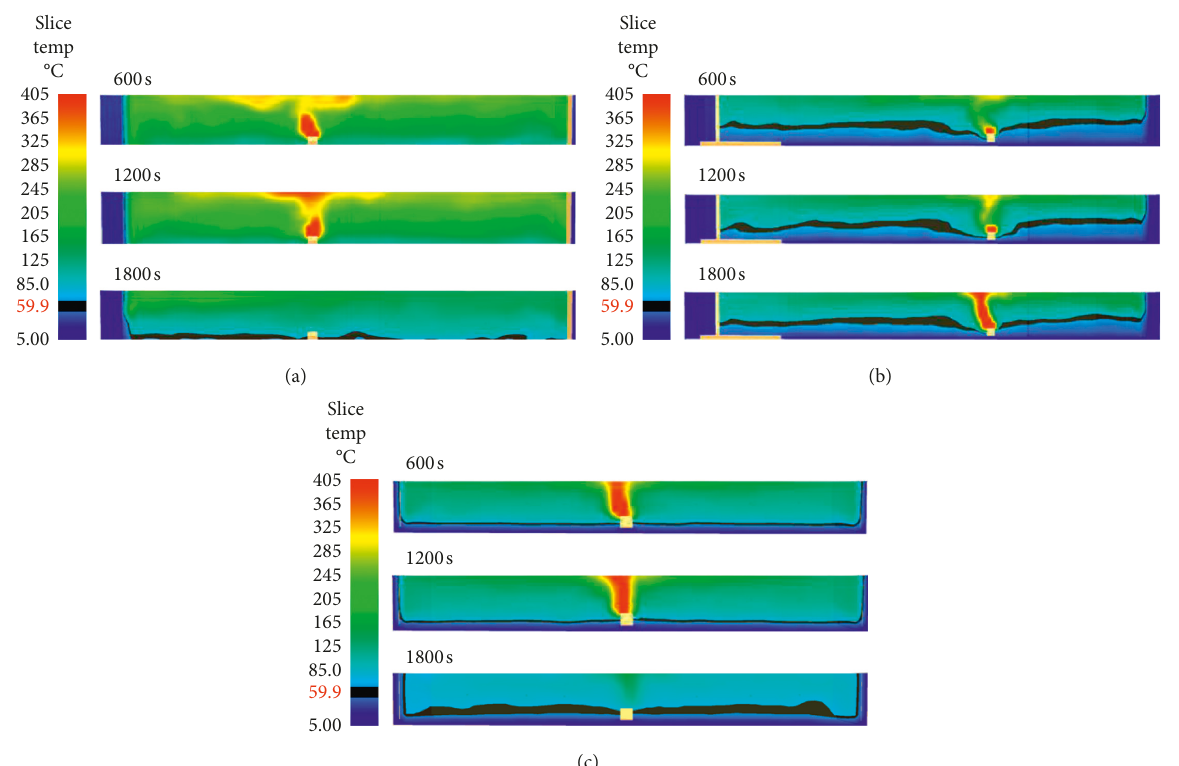
Figure 6: Slices of the temperature in different scenarios. (a) A10, (b) B10, and (c)